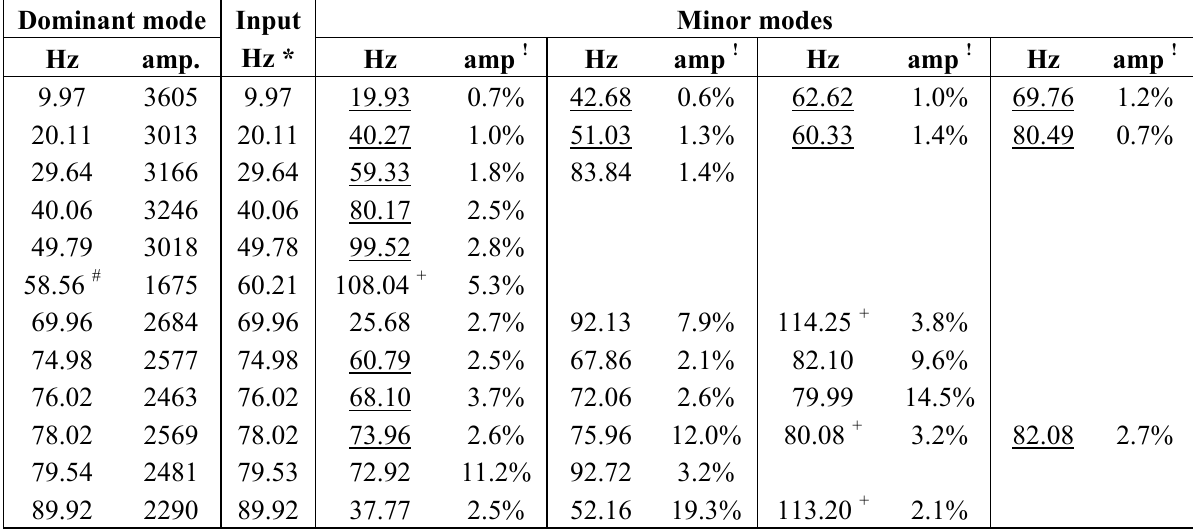
Table 2. Frequency response of the high speed camera.